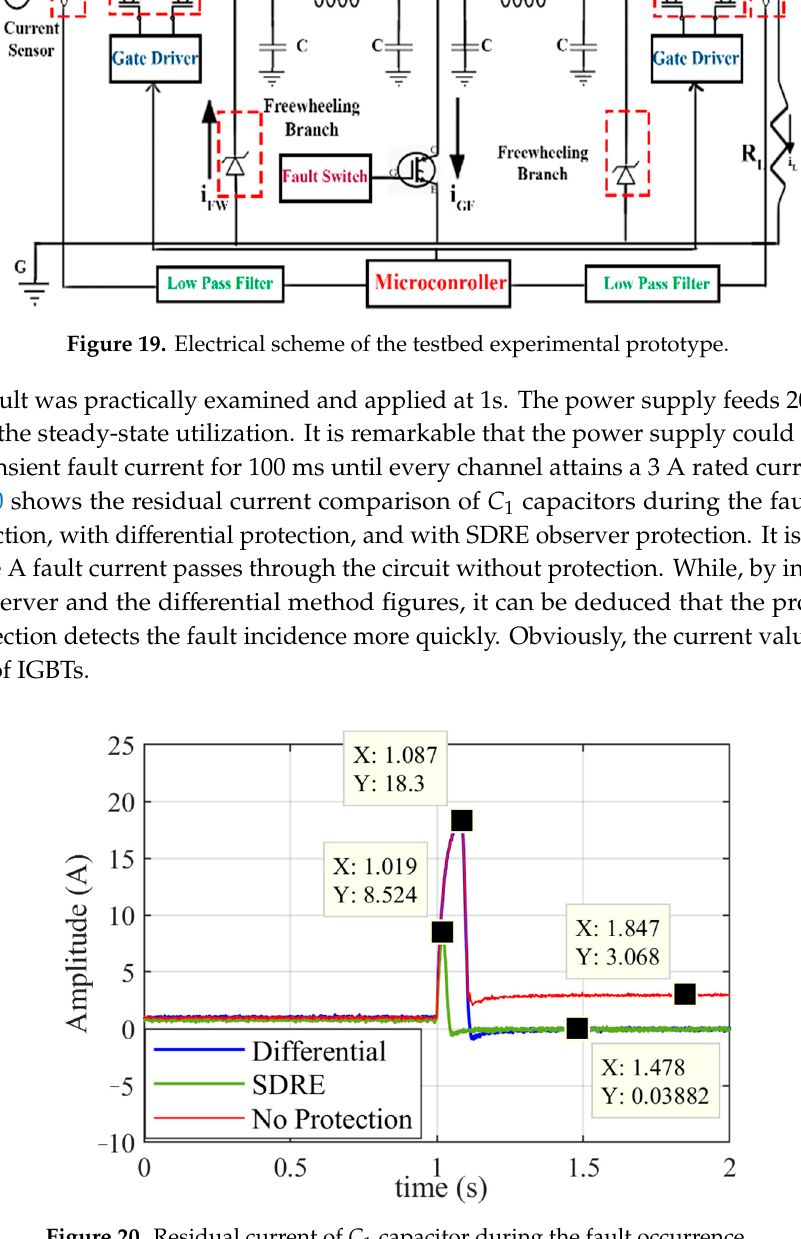
Figure 20. Residual current of C 1 capacitor during the fault occurrence.